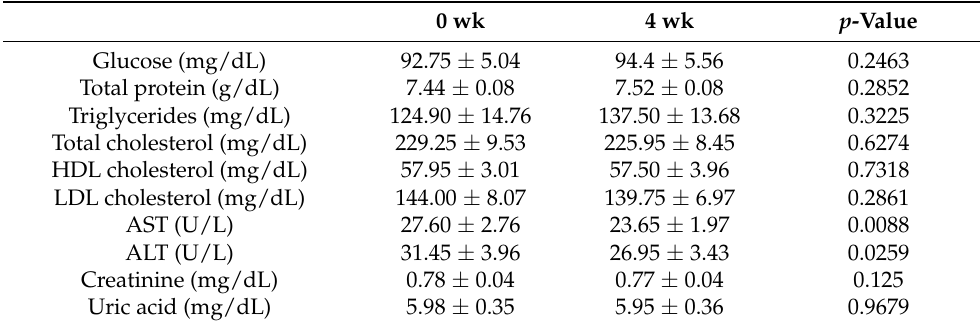
Table 2. Plasma biochemistry of subjects enrolled in this study.